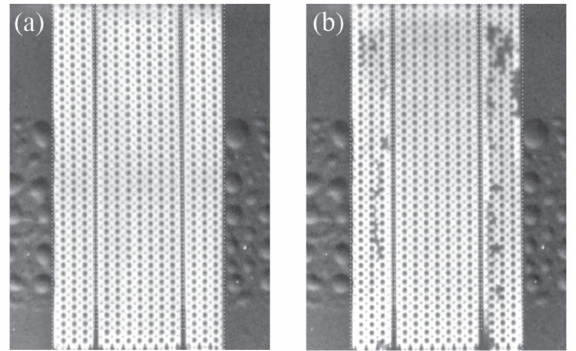
Figure 6. Fluorescence images of the microfluidic chamber filled with the sample mixture (0.25 mM of 4MU, 0.25 mM of Fl, 0.25 mM of R6G, 0.2% of HPMC in 10 mM HEPES, pH 7.0), ( a ) before the separation process and ( b ) after the separation process. Gas bubbles are identifiable as non-fluorescent regions inside the electrode